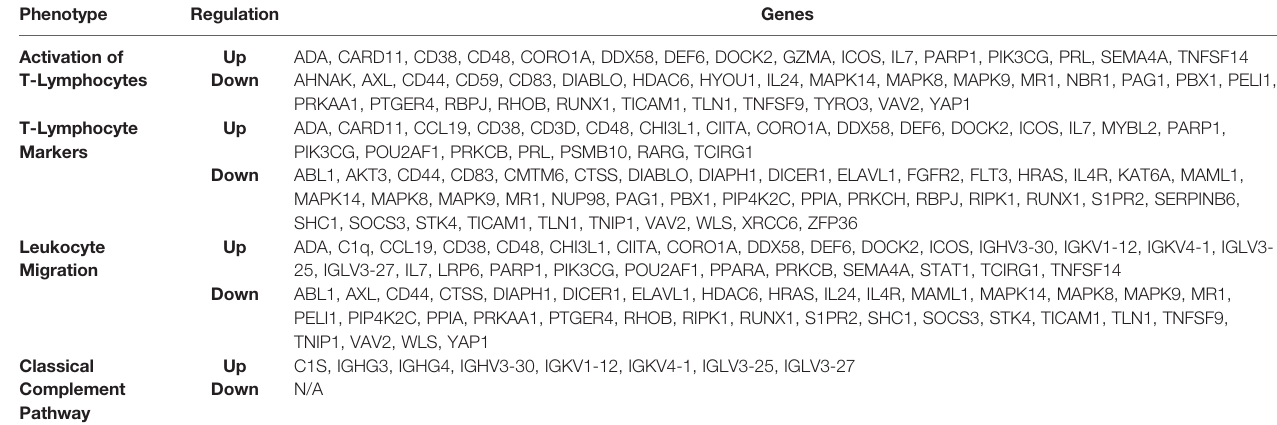
TABLE 1 | Differentially expressed genes in severe COVID-19